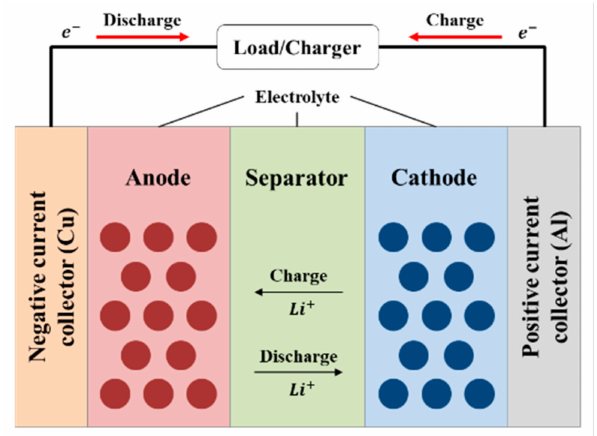
Figure 1. Schematic of the Li-ion battery